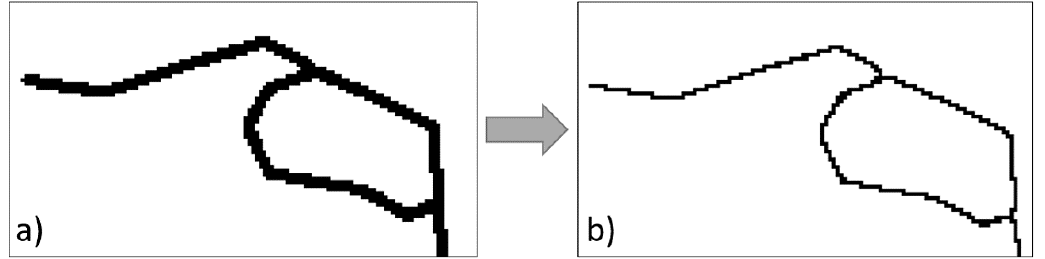
Figure 3. Preprocessing of images: ( a ) binarization and ( b ) shrinkage.